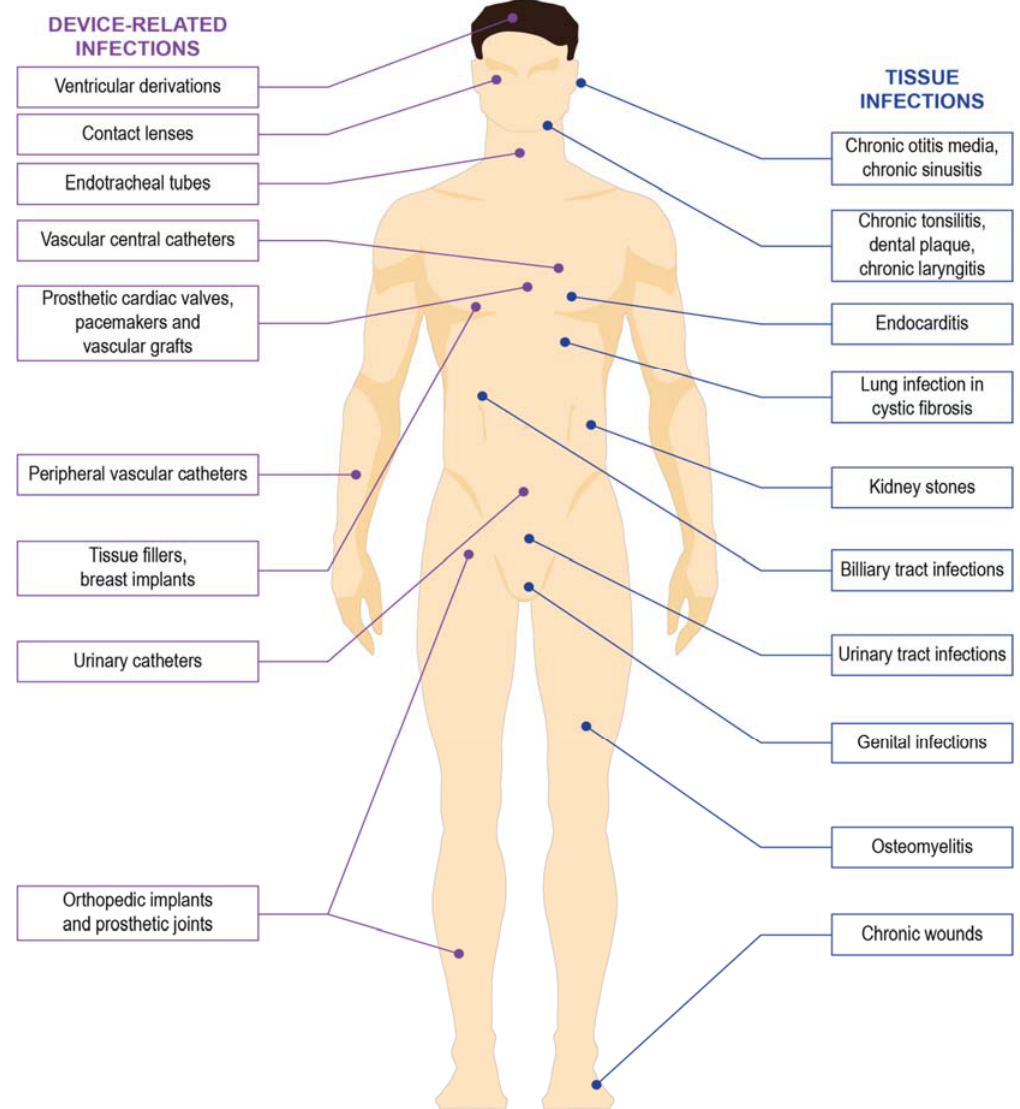
Figure 1. Common site of infections related to the formation of bacterial biofilms.